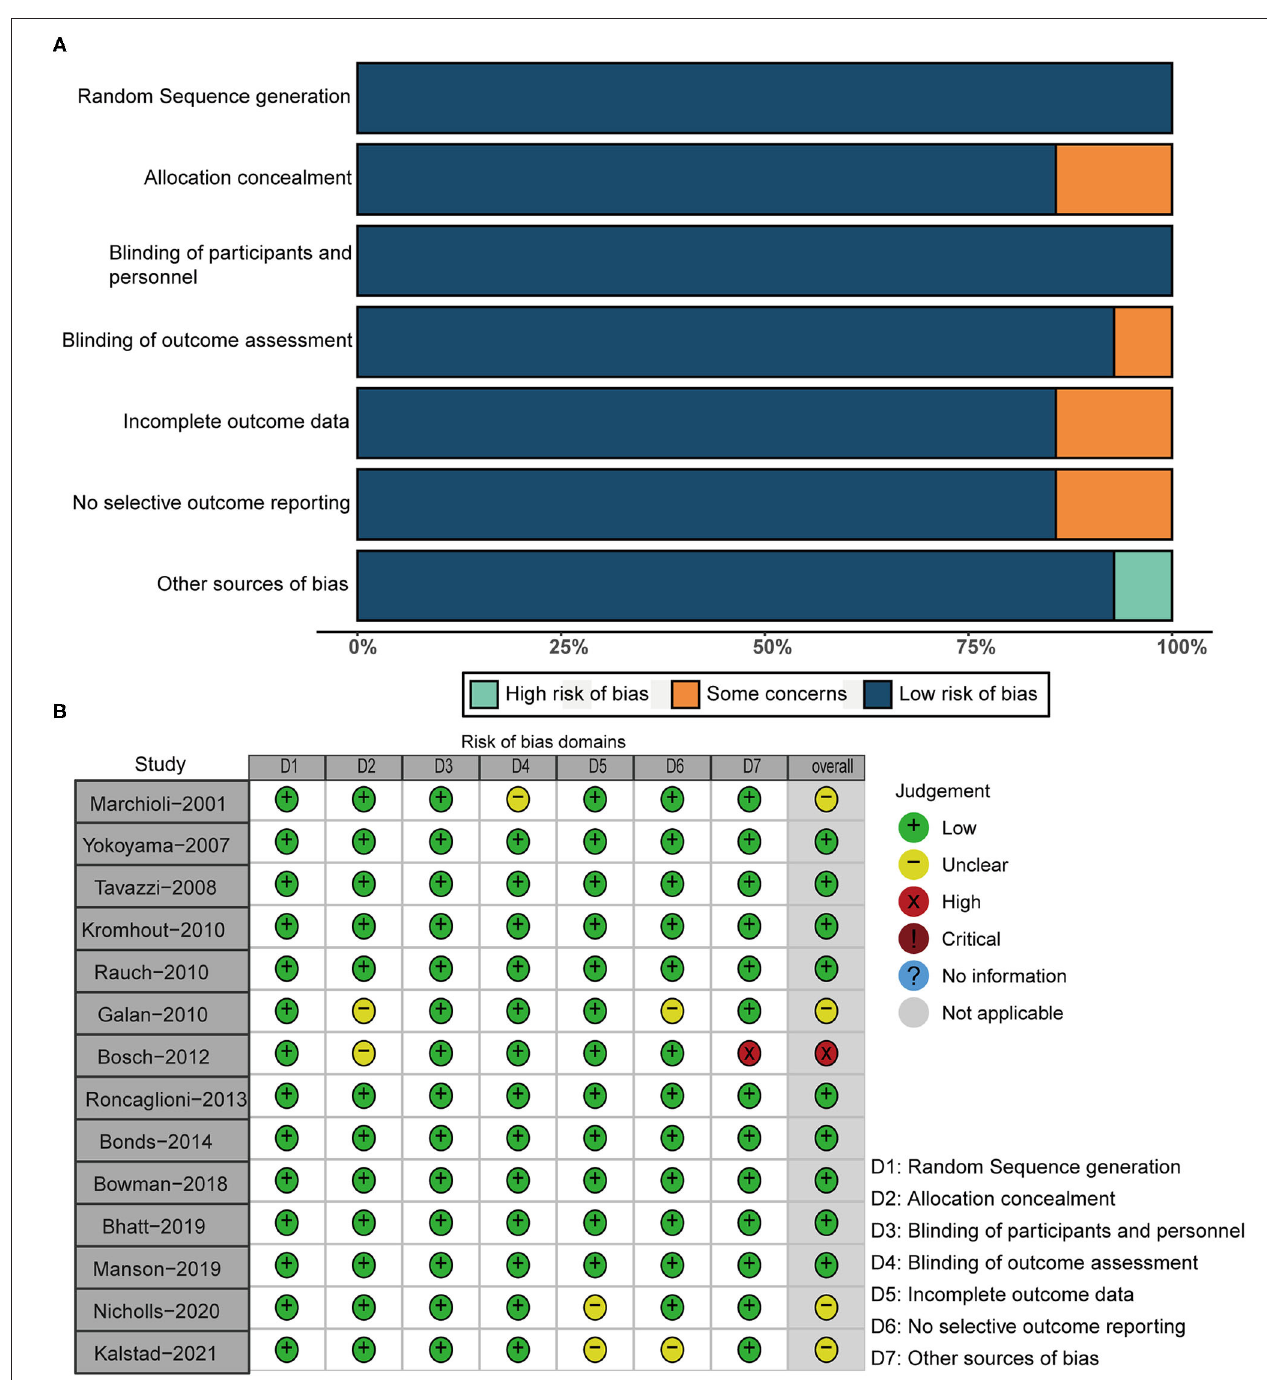
FIGURE 2 | Risk of bias plot. (A) Risk of bias summary; (B) risks of bias of each included study.